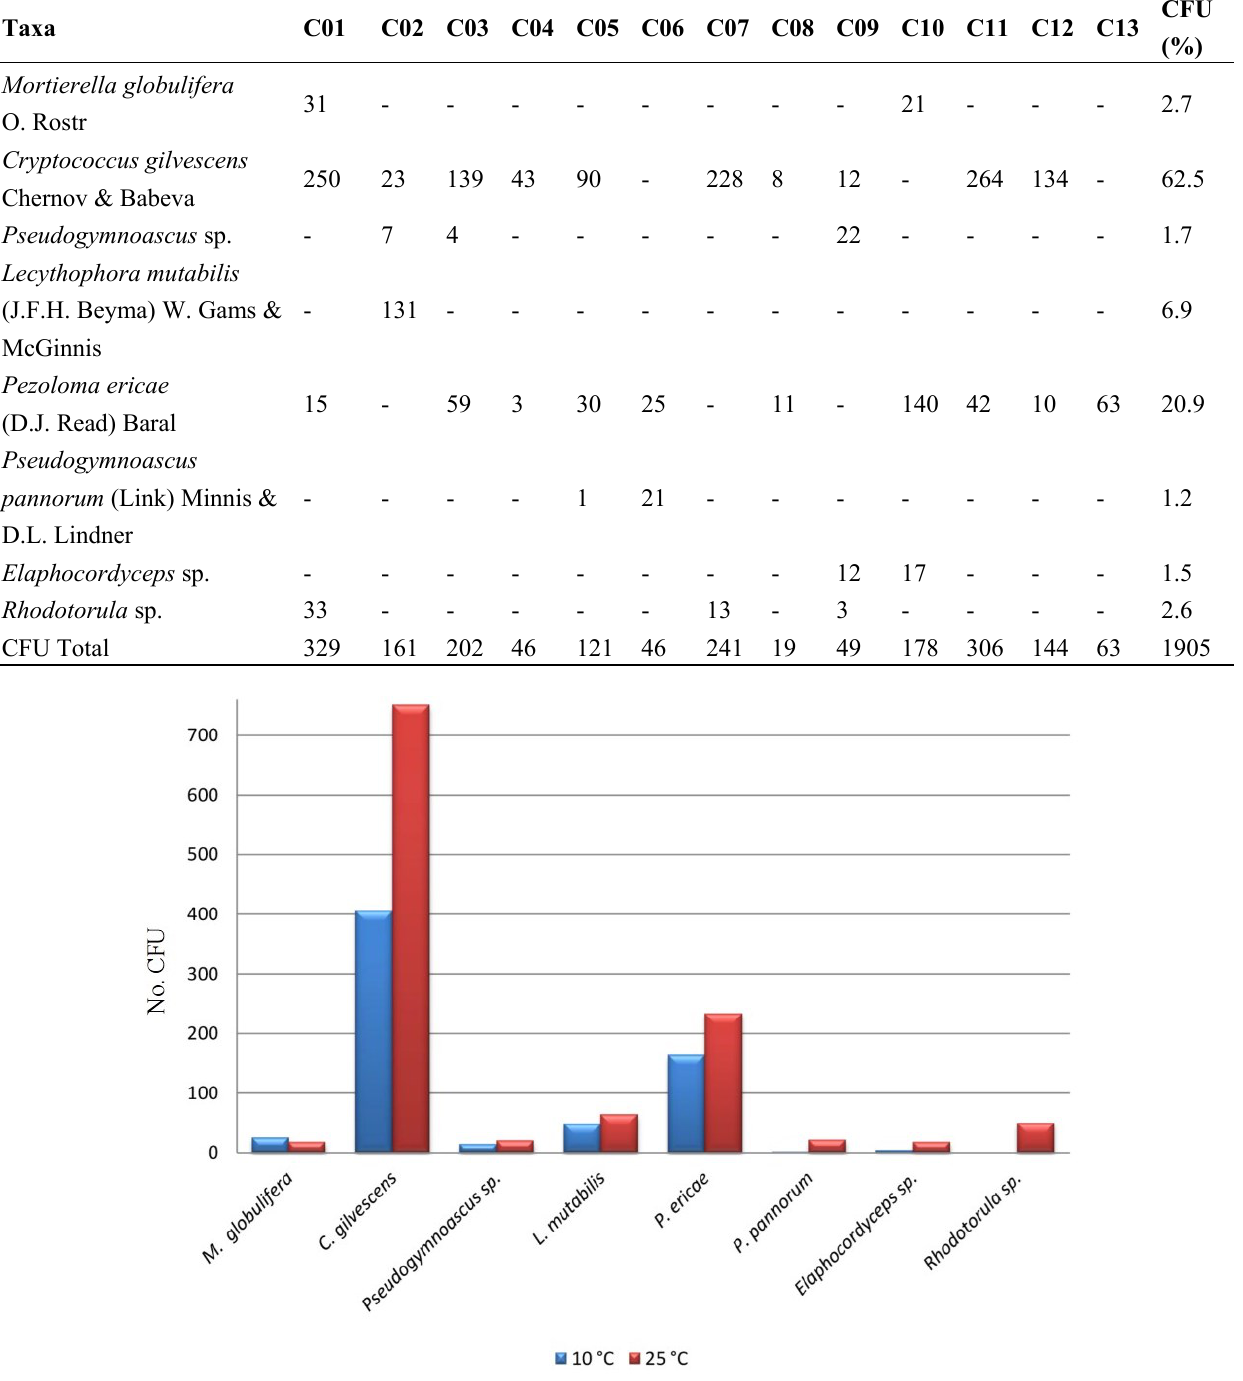
Table 3. Abundance (number of CFU) of fungal species isolated from the crust samples. Taxa